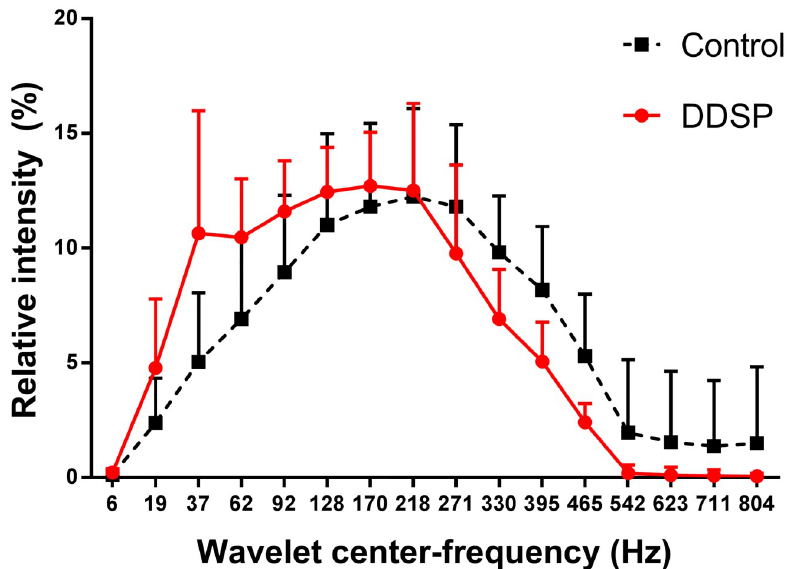
Fig 5. Wavelet decomposition of the thyro-hyoid muscles electromyographic activity in exercising horses. Relative contribution (% of the total intensity) of the center frequency of the 16 wavelets to the thyro-hyoid muscles electromyographic activity shows a relative shift towards lower frequencies in horses affected by palatal instability and intermittent displacement of the soft palate (DDSP) compared to normal horses (control). Data expressed as mean ±